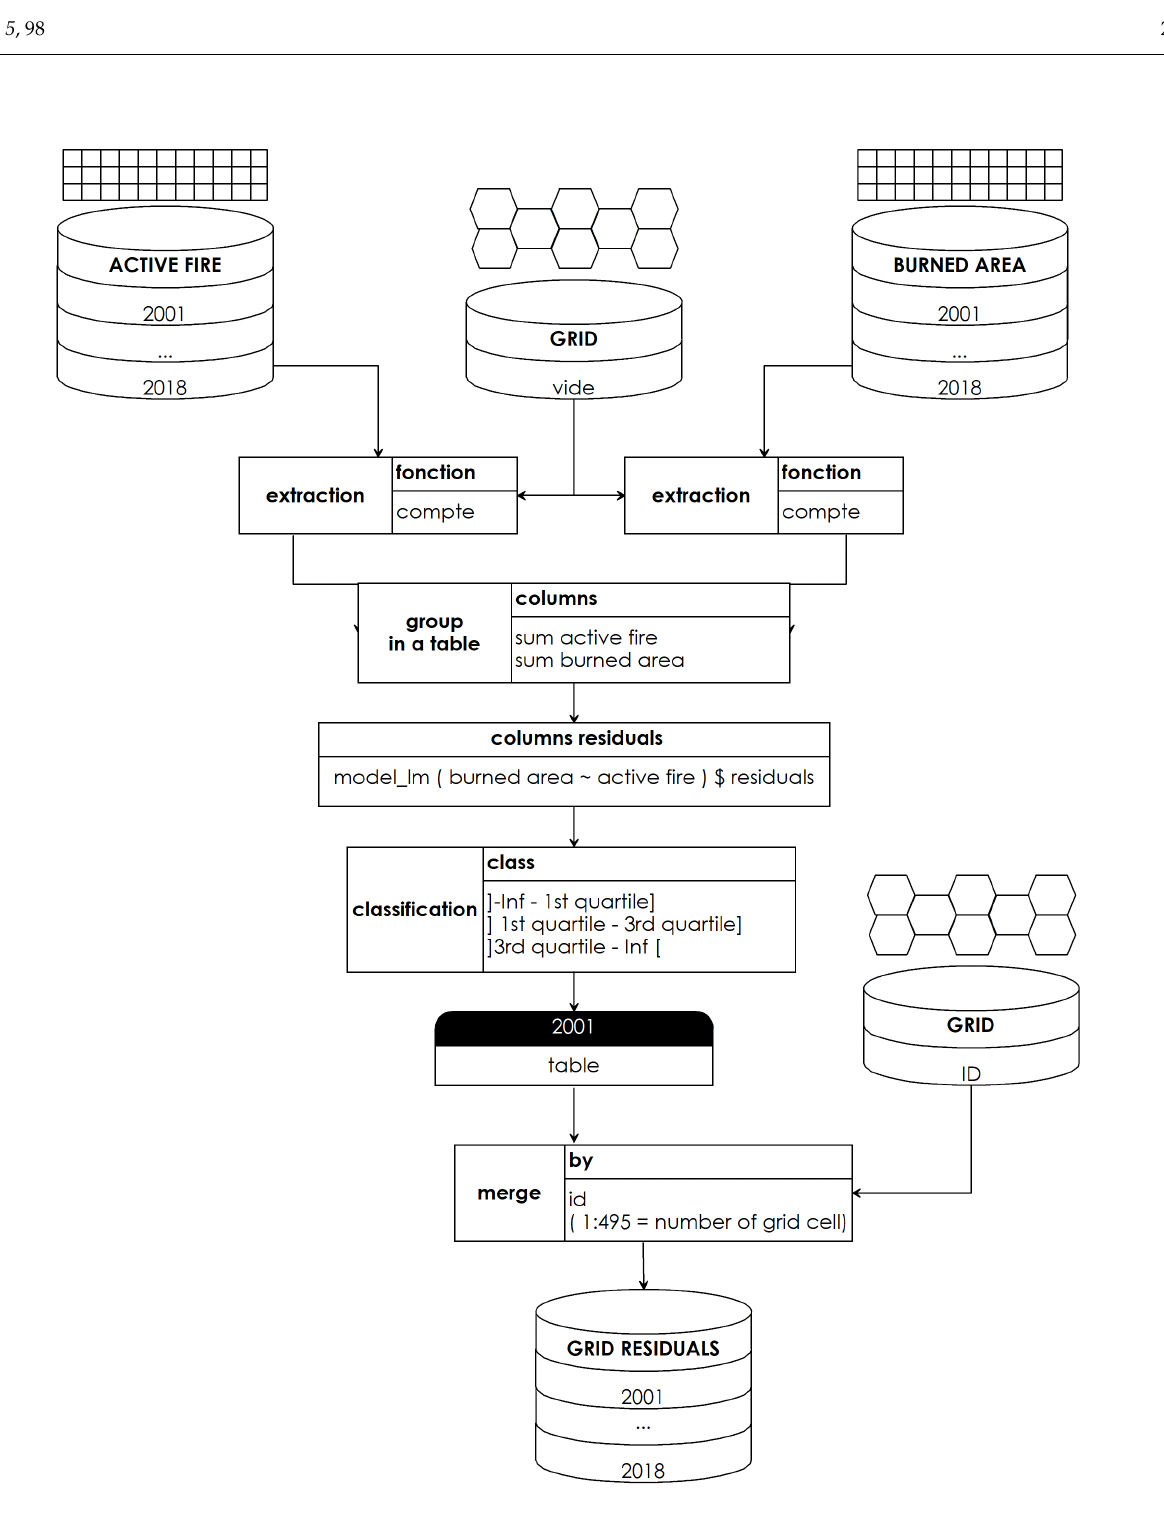
Figure A2. Processing of MODIS